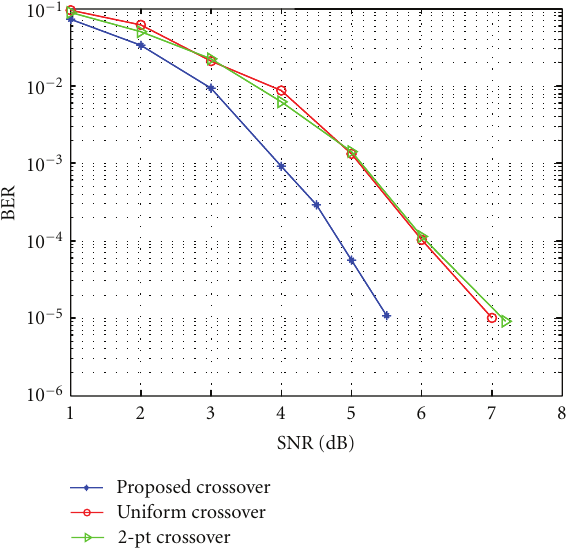
Figure 7: E ff ect of crossover rate on performances.